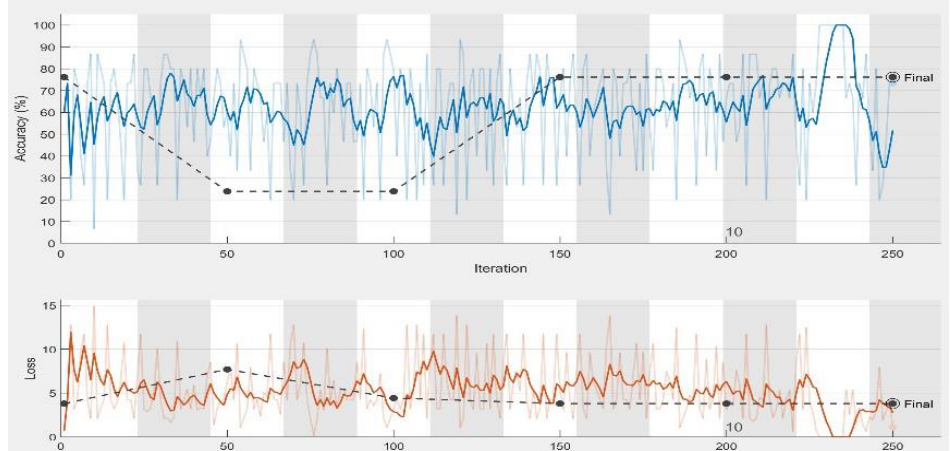
Figure 9. AlexNet training process with a learning rate of 0.01. The figure shows the epoch number, training accuracy (blue line), validation accuracy (black line), and loss function value for the training data (red line) and validation data (black line).